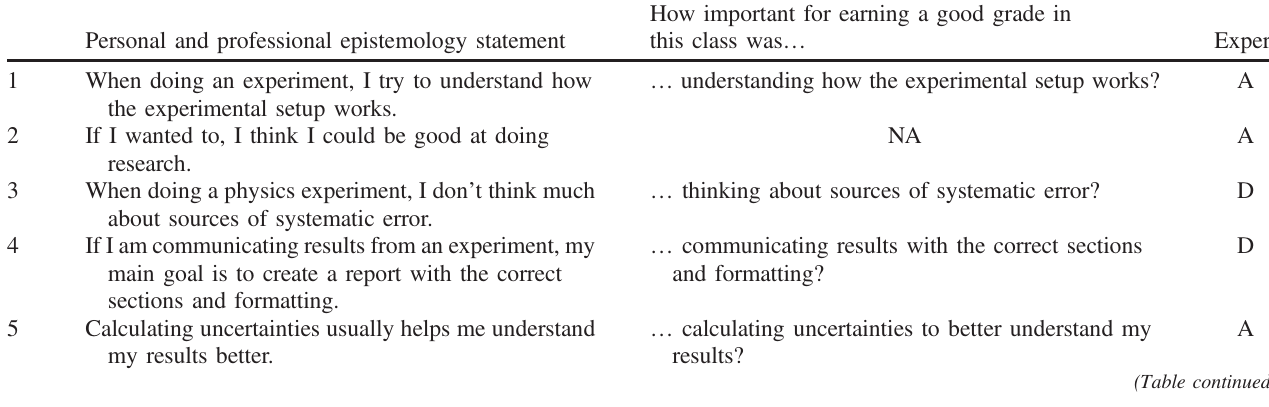
TABLE III. List of all E-CLASS statements. The personal and professional epistemology statements go with the pair of questions “ What do YOU think when doing experiments for class? ” and “ What would experimental physicists say about their research? ” . The third column lists the expectation question that forms a triplet with the personal and professional epistemology question. NA means no expectation question is associated with that particular epistemological construct. The final column gives the expert consensus (A is agree, D is disagree). Question 23 is omitted because it is a check question to make sure students are reading the